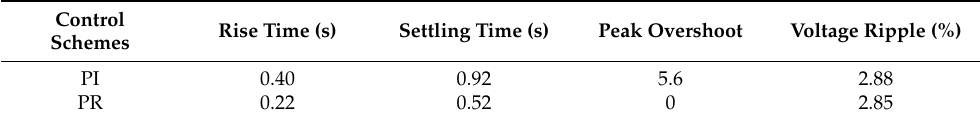
Table 4. Experimental results of the voltage step change.